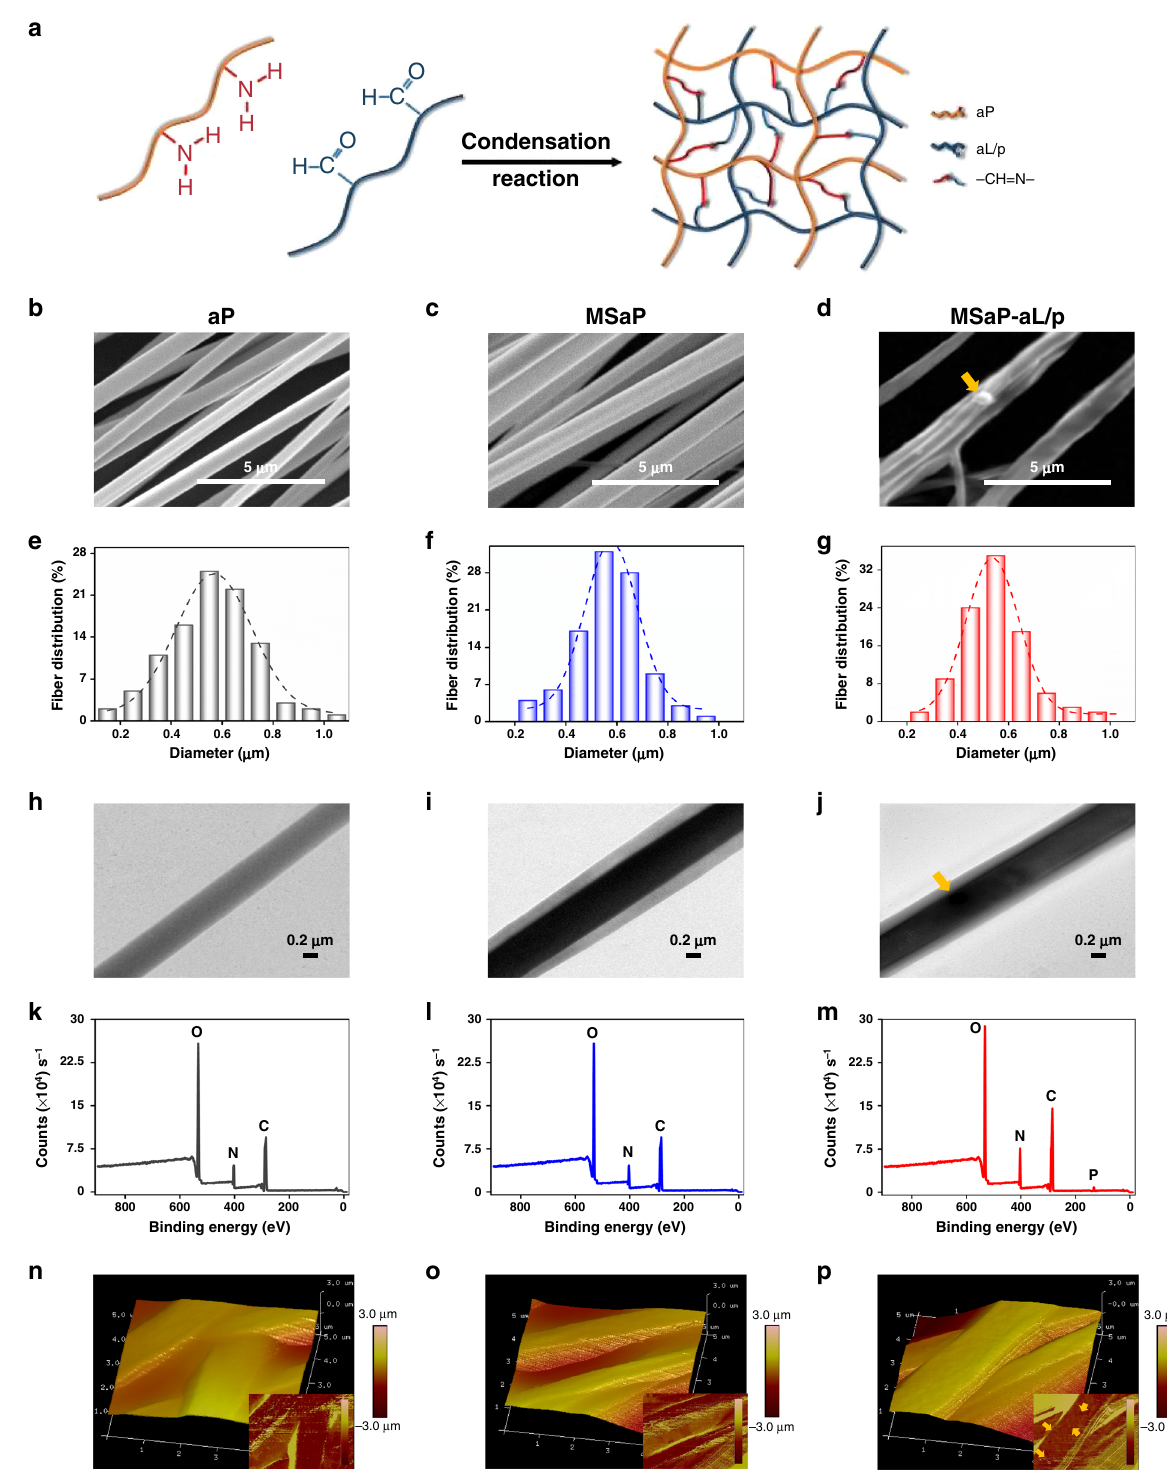
Fig. 4 The morphology of different fi ber scaffolds. a Schematic diagram of amino polylactic acid microsol electrospun fi ber and aldehyde cationic liposomes connected with Schiff base. b – d SEM images of different fi ber scaffolds (three independent experiments). e – g Histogram of frequency distribution of different fi ber scaffolds diameters ( n = 100 fi bers from each sample). h – j TEM images of different fi ber scaffolds (four independent experiments). k – m XPS indicating chemical elements on different fi ber scaffold surfaces. n – p AFM images of scaffolds (three independent experiments). The yellow arrows in the images indicate the location of liposome ( n = 3, all SEM scale bars were 5 µ m, all TEM scale bars were 0.2 µ